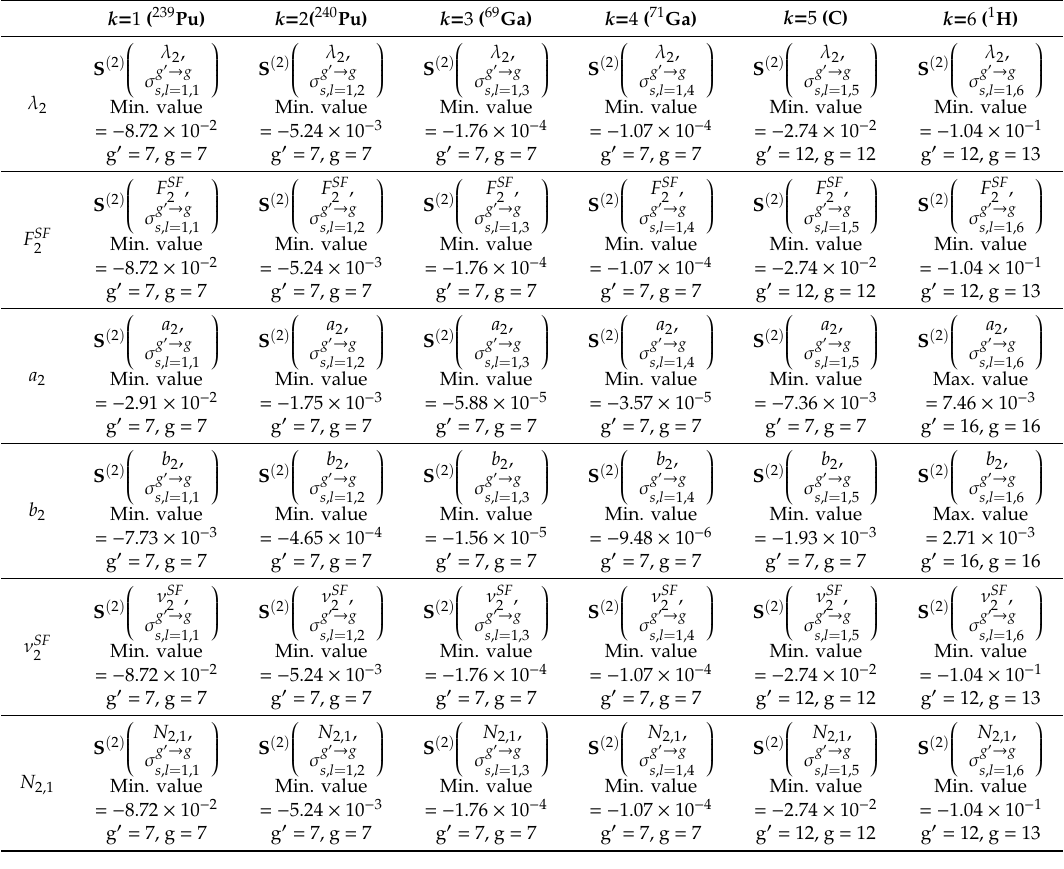
Table 11. Summary presentation of the matrix S ( 2 ) the leakage response with respect to the source parameters of isotope 240 Pu and the 1st-order ( l = 1 ) scattering cross sections for all isotopes in the PERP